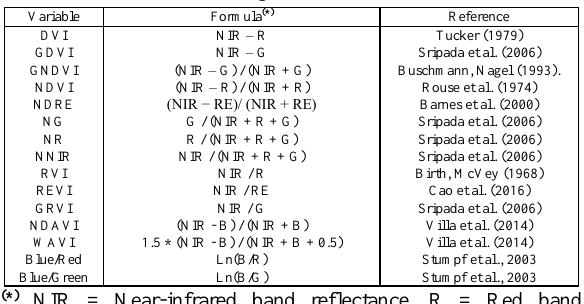
Vegetation indices and bathymetric ratios computed for the UAV image of Souris.